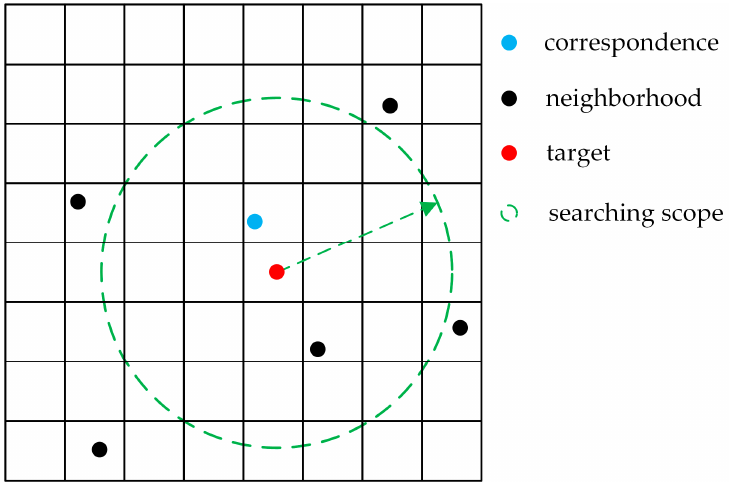
Figure 3. Radius search on BEV image of LiDAR. The red point is the input target point. The blue point is one of the neighborhoods with the maximum correlation coefficient with the descriptor of the In the main text below Figure 8. "on the same level as a result from KITTI dataset" can be corrected to "on the same level as the result from KITTI dataset".